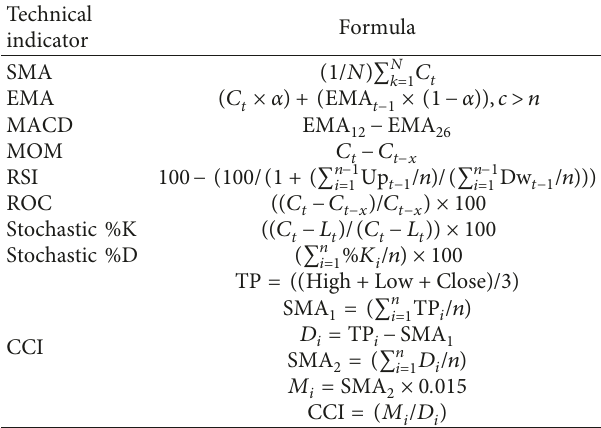
Table 1: Formulas of technical